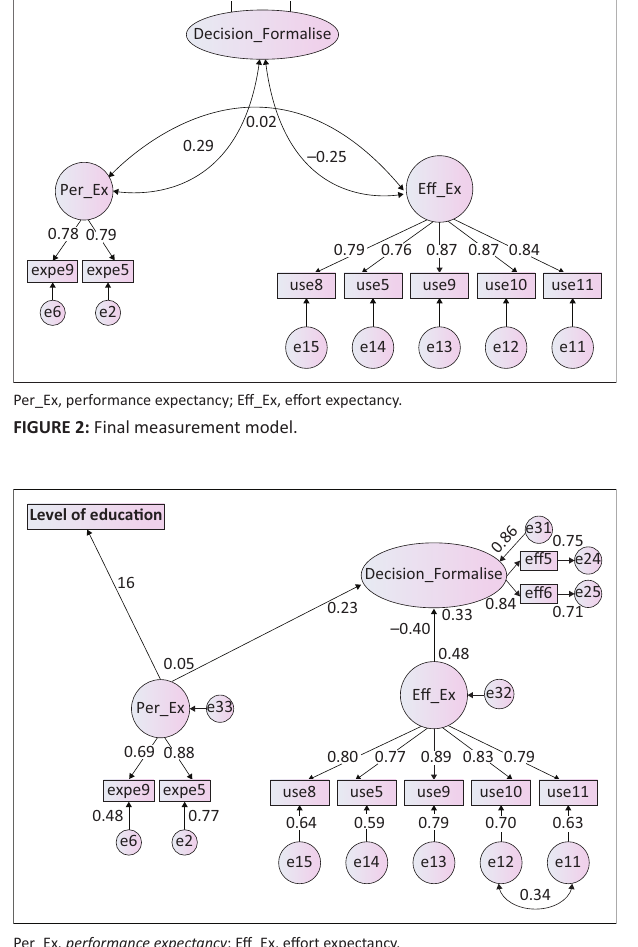
FIGURE 3: Final structural model.